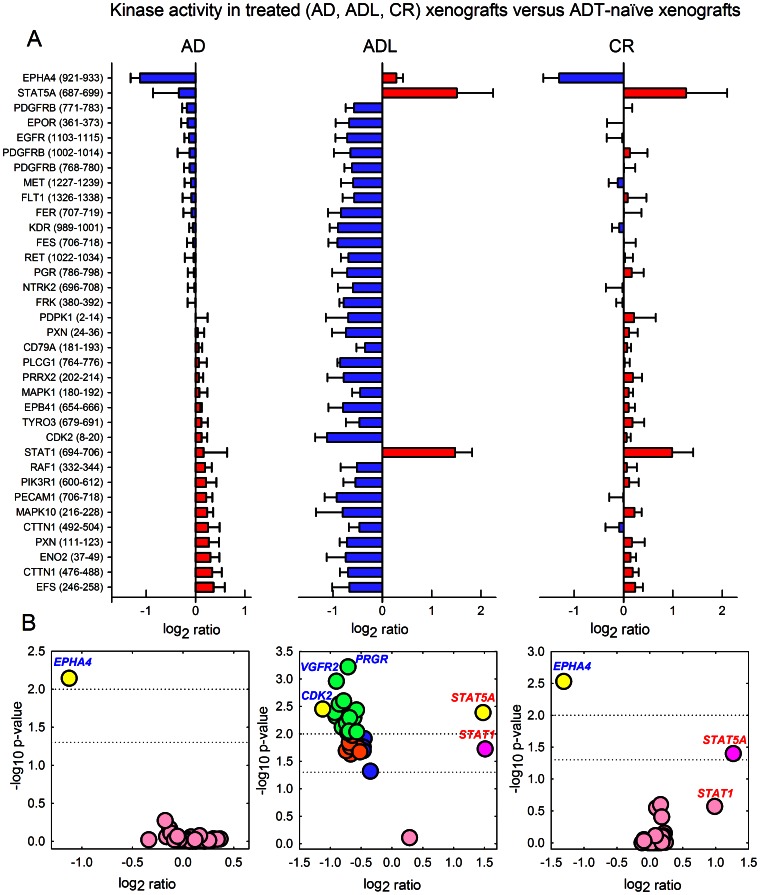
Kinase activity in xenografts following androgen-deprivation therapy (ADT).(A) Decreased (blue; negative log2 ratio) and increased (red; positive log2 ratio) phosphorylation levels of kinase peptide substrates by androgen-deprived (AD), long-term AD (ADL), and castration-resistant (CR) prostate carcinoma xenografts compared to ADT-naïve tumors (mean ratio and s.e.m. per substrate). Protein lysates from three biological replicates from each of the four experimental groups (ADT-naïve, AD, ADL, CR) were analyzed to generate the xenograft kinase activity profiles. Listed are the substrates’ corresponding gene names, with start and end positions for the peptide sequence within the protein in brackets. (B) Volcano plots (−log10 p-values versus ratios) visualizing kinase peptide substrates with most significant and/or highest log2 ratios between treated and ADT-naïve tumors’ phosphorylation levels. Color labeling: yellow: p<0.01 and ratio >1.0; green: p<0.01 and ratio = 0.5–1.0; dark pink: p = 0.01–0.05 and ratio >1.0; orange: p = 0.01–0.05 and ratio = 0.5–1.0; blue: p = 0.01–0.05 and ratio <0.5; light pink: p>0.05.